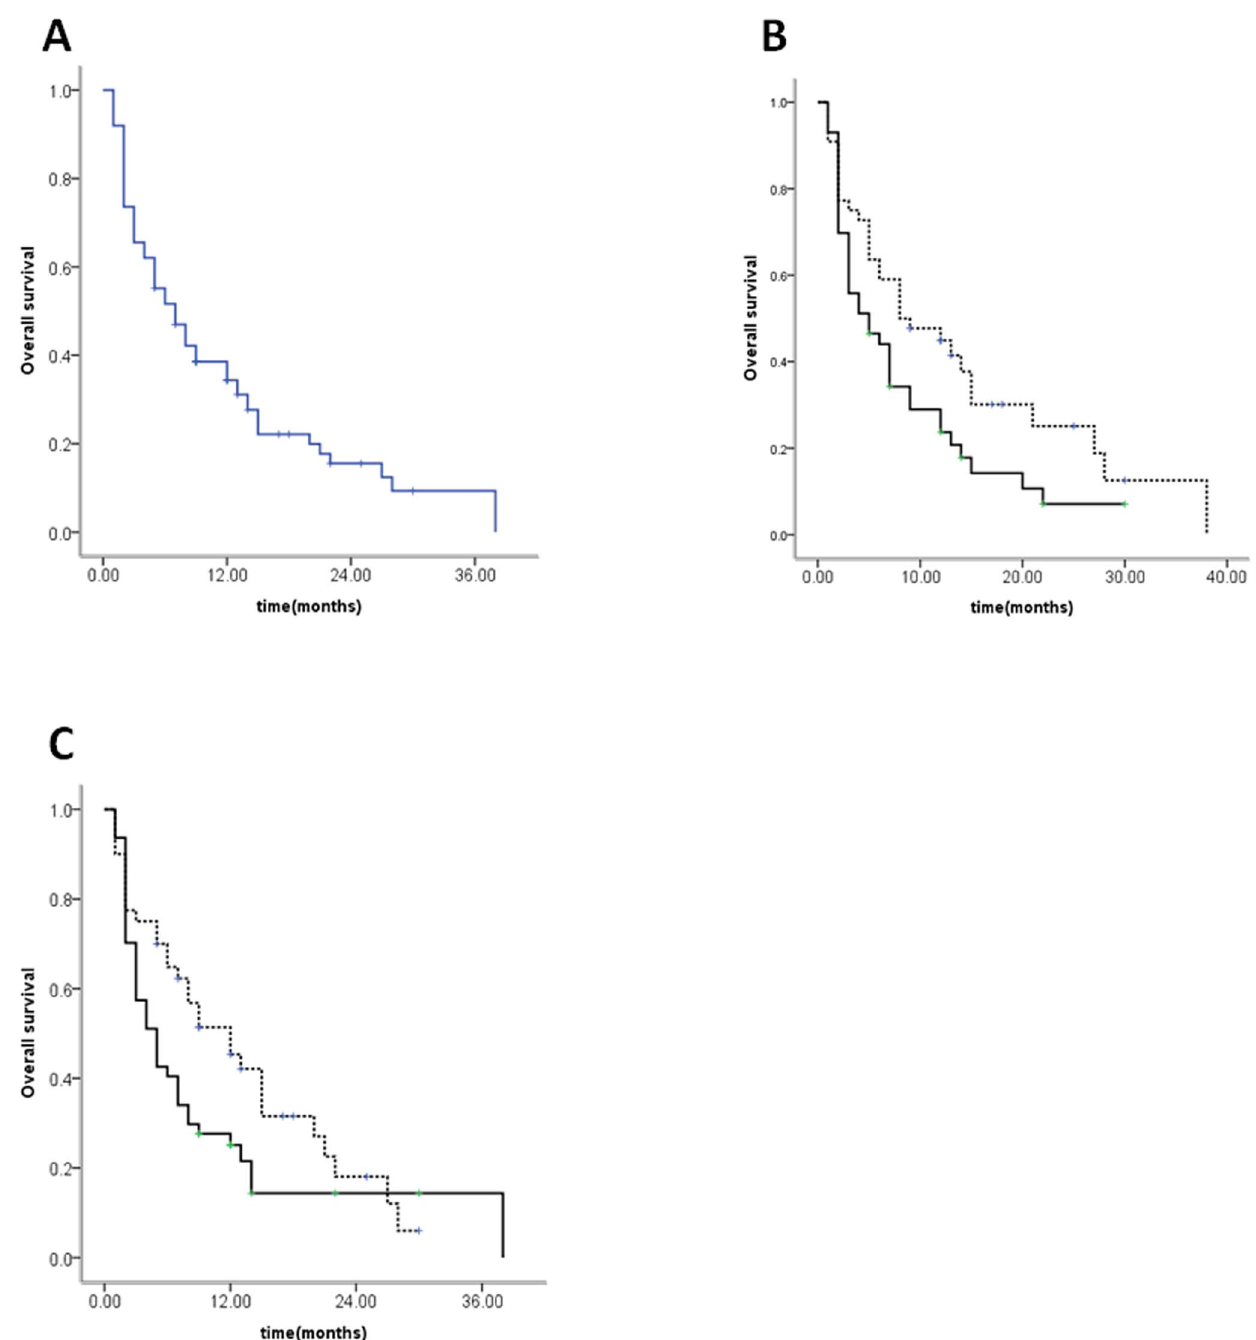
Figure 1. Survival curves of HCC patients. (A) Overall survival of all the HCC patients after initial diagnosis of extrahepatic metastasis. The cumulative survival rates at 12 and 36 months were 34.4% and 9.3%, respectively. (B) Comparison of survival rates between patients with or without active intrahepatic lesions (solid line: with active intrahepatic lesions (n=89), dash line: without active intrahepatic lesions (n=43), P=0.037). (C) Comparison of survival rates between patients with or without lymph node metastases (solid line: with lymph node metastases, dash line: without lymph node metastases, P =0.036).